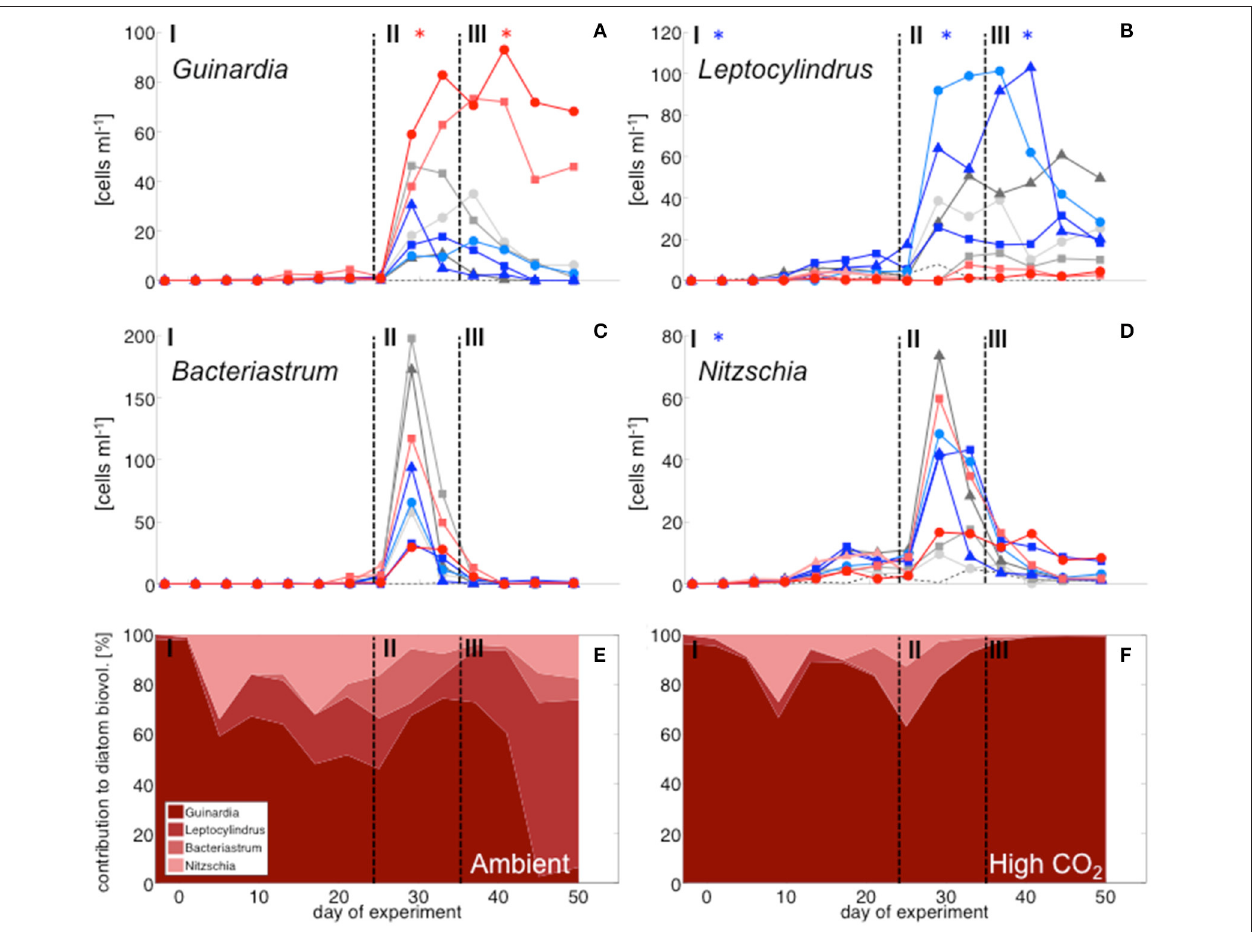
FIGURE 4 | Diatom community composition derived from microscopy. Abundance of (A) Guinardia striata , (B) Leptocylindrus danicus , (C) Bacteriastrum delicatulum , and (D) Nitzschia sp . Color code and symbols as in Figure 2 . (E,F) : relative contribution of different taxa to total diatom biovolume under (E) ambient CO 2 (M1, M9) and (F) in the high CO 2 mesocosms (M2,